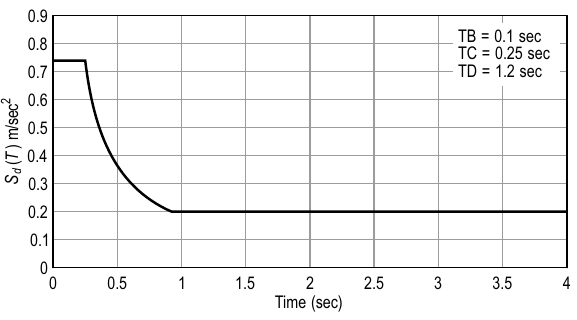
Fig. 1. ECP-201 (2008) design response